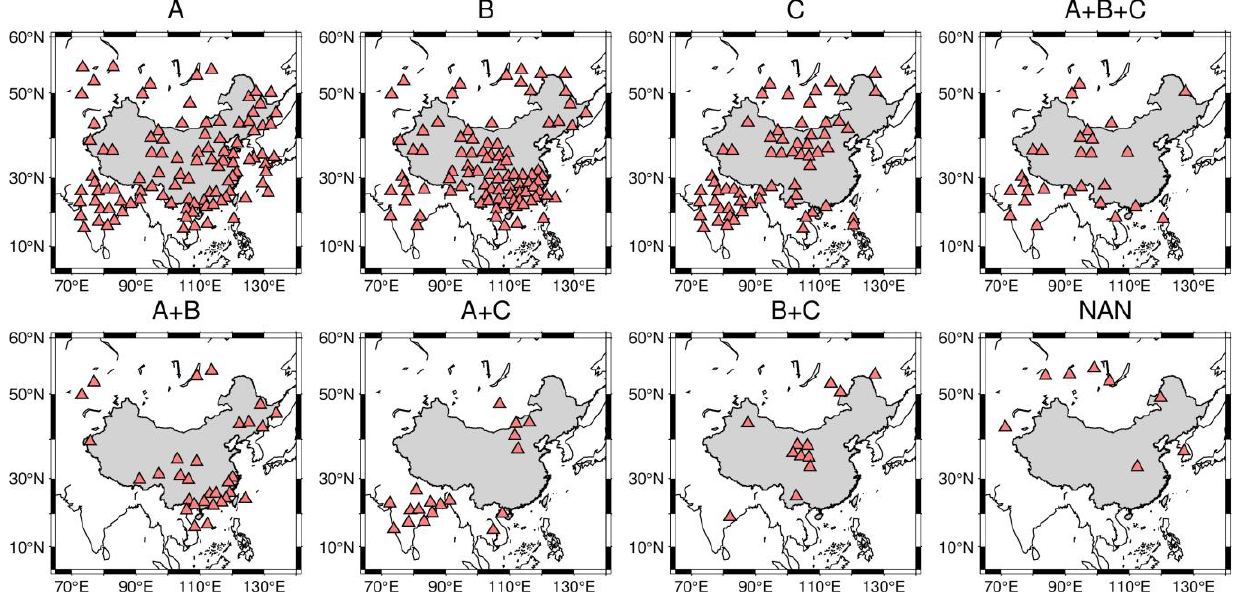
Figure 3. Distribution of sites with different types of variations.